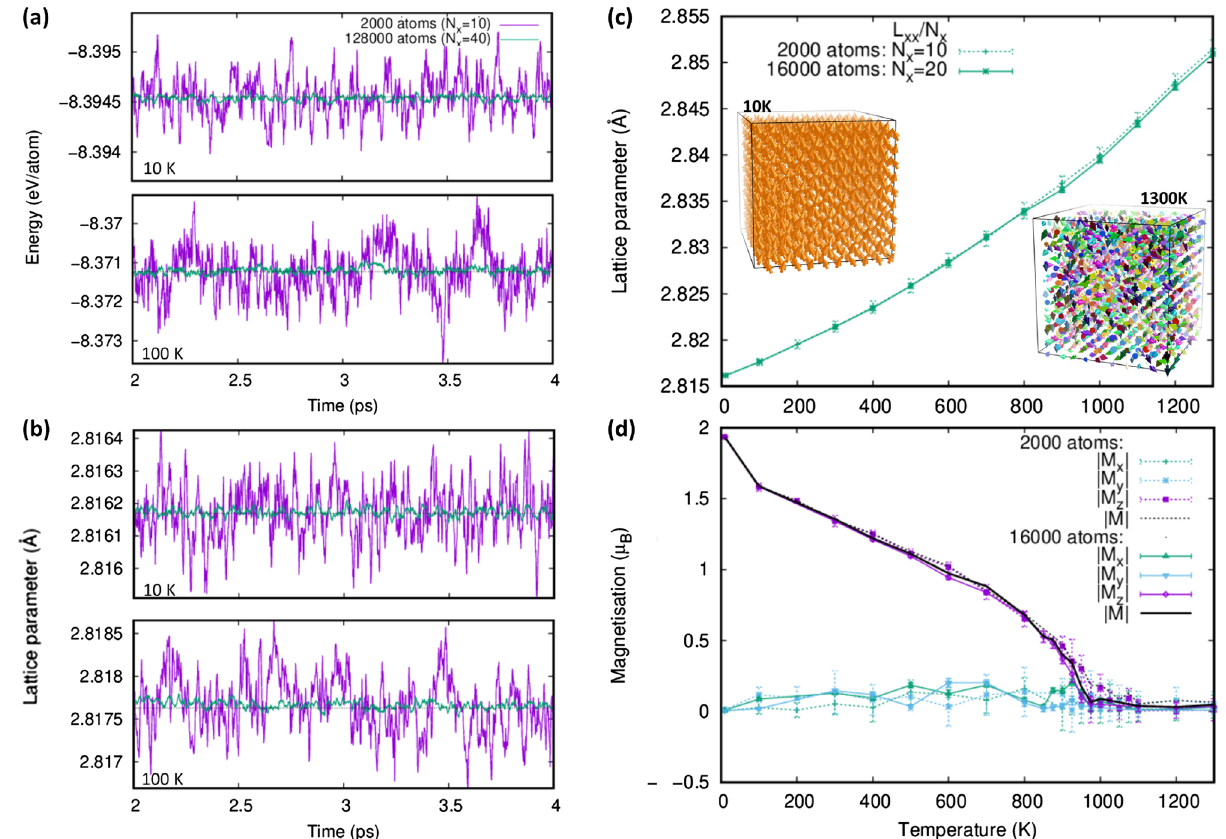
Figure 1. Dynamic stability and properties of the machine-learned spin-lattice dynamics potential (MSLP) for iron. Comparison of instantaneous ( a ) total energies per atom and ( b ) lattice parameter per unit cell between 10 10 ) and 128,000 atom ( 40 40 40 ) simulation cells at 10 K and 100 K. ( c ) Lattice 2000 atom ( 10 × × × × M M (cid:31) constants and ( d ) magnetization ( i | / N ) calculated using our MSLP for iron using a simulation i | | = | boxes containing 2000 and 16,000 atoms. Standard deviation of data are shown as error bars. Details are in Supplementary materials. Subfigures in ( c ) show snapshots of the ferromagnetic arrangement of magnetic moments at 10 K and the paramagnetic state at 1300